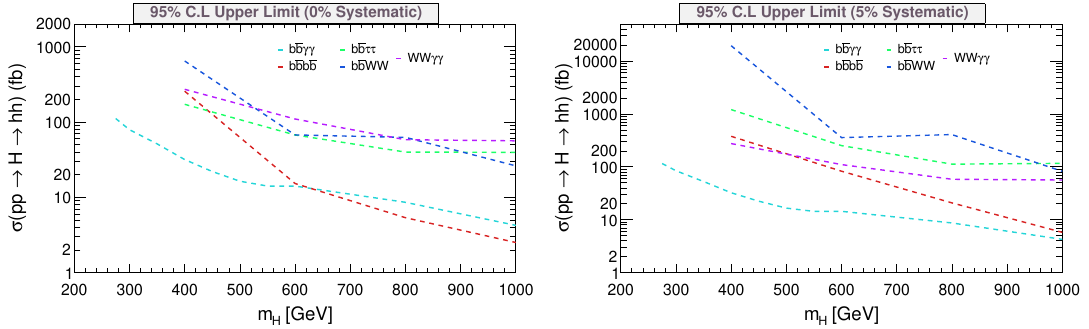
Figure 28 . 95% CL upper limit on (cid:27) ( pp b (cid:22) b(cid:13)(cid:13); b (cid:22) bb (cid:22) b; b (cid:22) b(cid:28) + (cid:28) (cid:0) ; b (cid:22) bWW (cid:3) (2 ‘ ) and WW (cid:3) (cid:13)(cid:13) (2 ‘ ) channels without systematic uncertainty (left) and with 5% systematic uncertainty